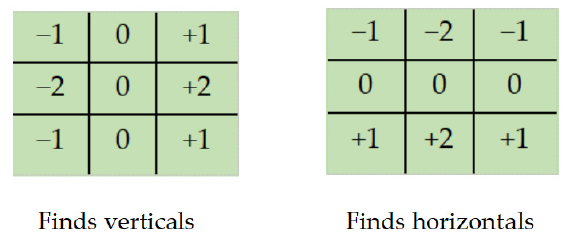
Figure 6. Sobel operator template.